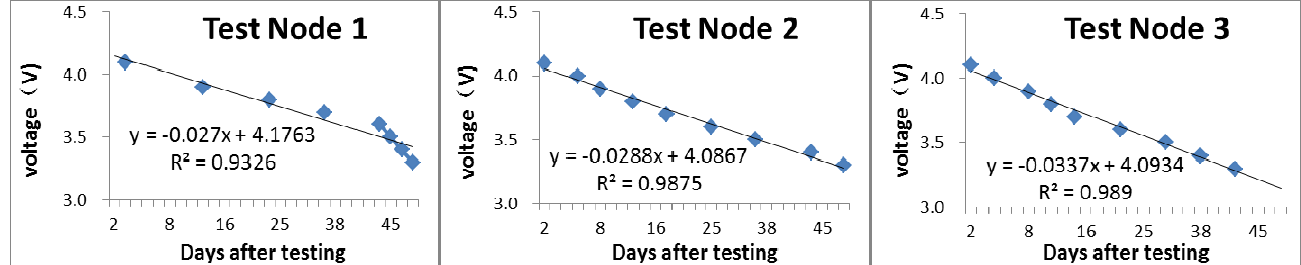
Figure 6. The cumulative operating time and voltage change trend of three test nodes. The subplot tile is the node number.